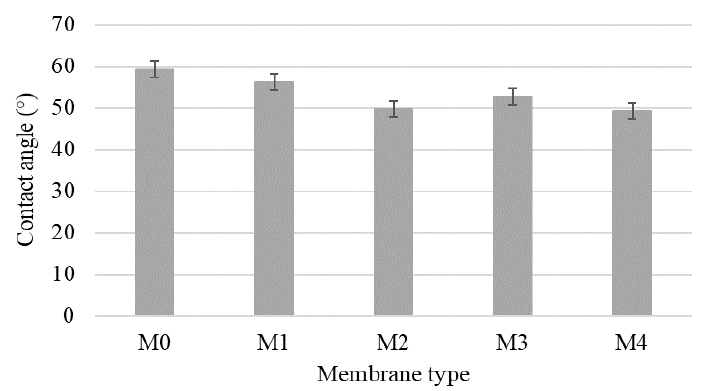
Figure 6. The contact angle of polyphenylene-ether-ether-sulfone (PPEES) and nanocomposite membranes.